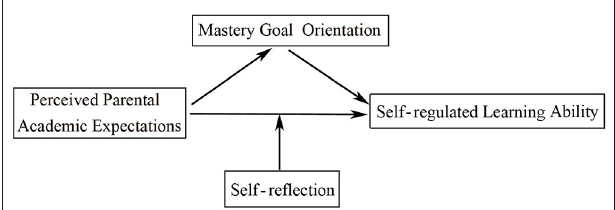
FIGURE 1 | The hypothesis model of the relationships between perceived parental academic expectations, mastery goal orientation, self-regulated learning ability, and